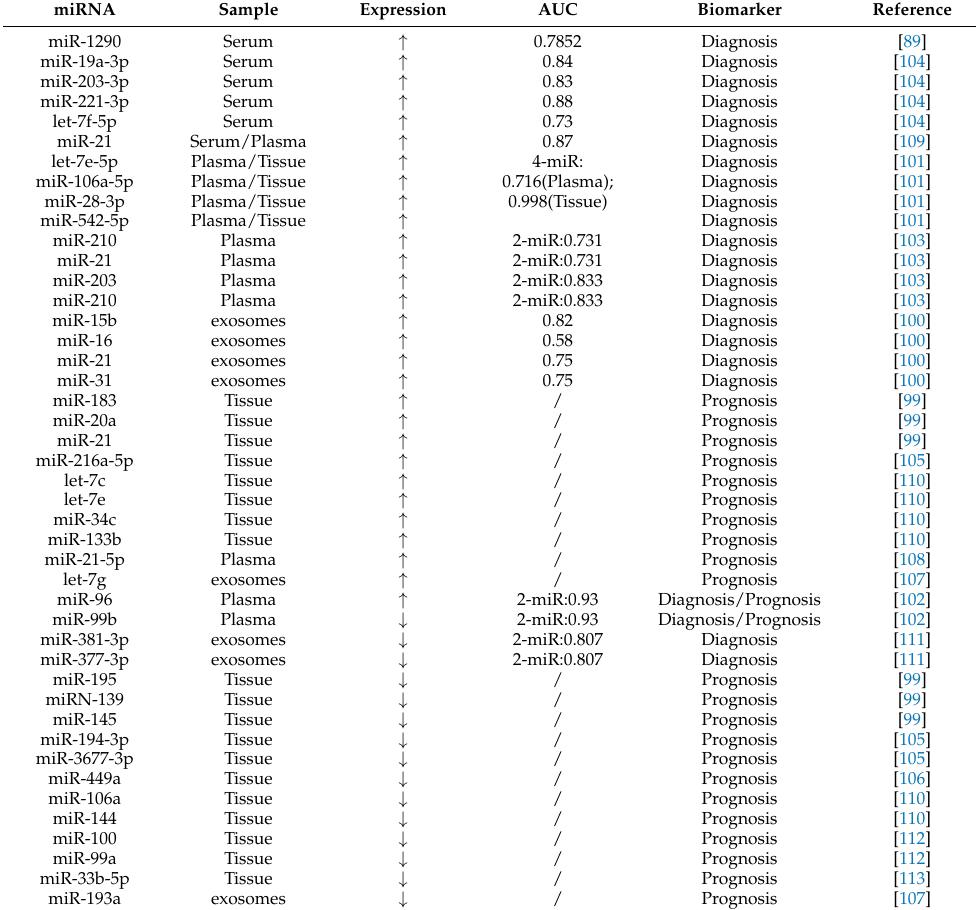
Table 4. MicroRNAs as biomarkers for diagnosis and prognosis of CRC. miRNA Sample Expression AUC